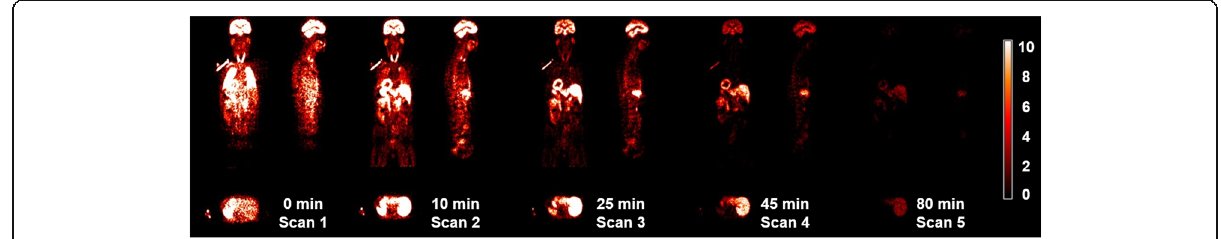
Fig. 2 Whole-body PET images of a representative subject at scans 1 – 5 after injection of 11 C-BU99008. Coronal, axial and sagittal sections are shown. Time refers to approximate start time of scan after injection of 11 C-BU99008